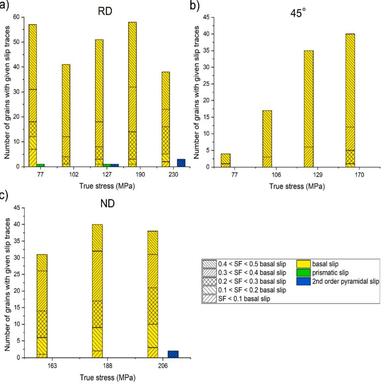
EBSD-based SF analysis of the RD sample: a) SF distribution map for the basal slip of the sample loaded up to 77 MPa, b) comparison of the SF distributions for the basal slip and extension twinning in the initial state and after loading up to 102 MPa.